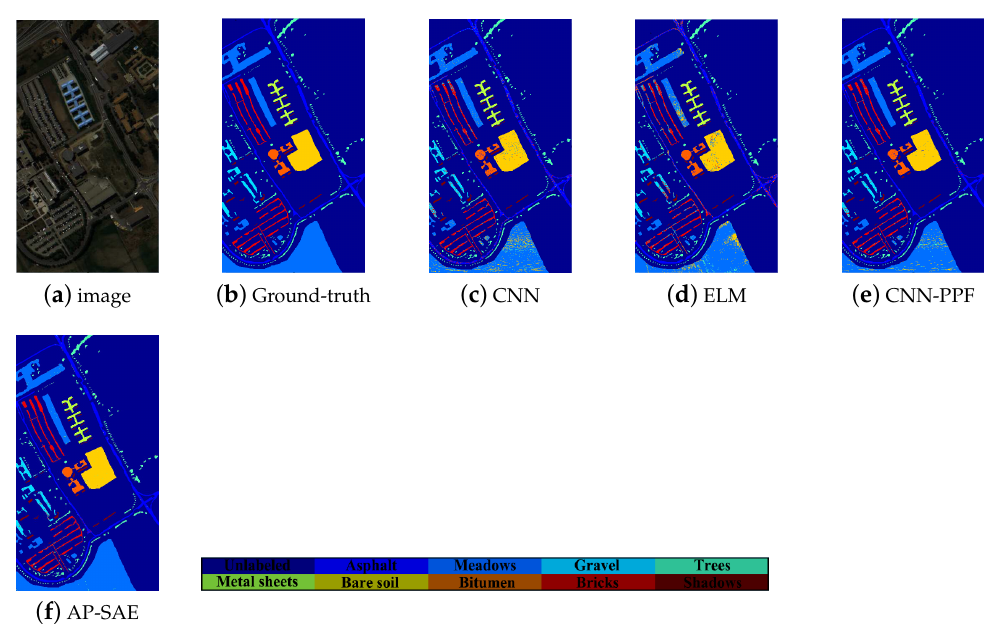
Figure 15. Classification result with nine classes for the University of Pavia data set,as thematic maps.